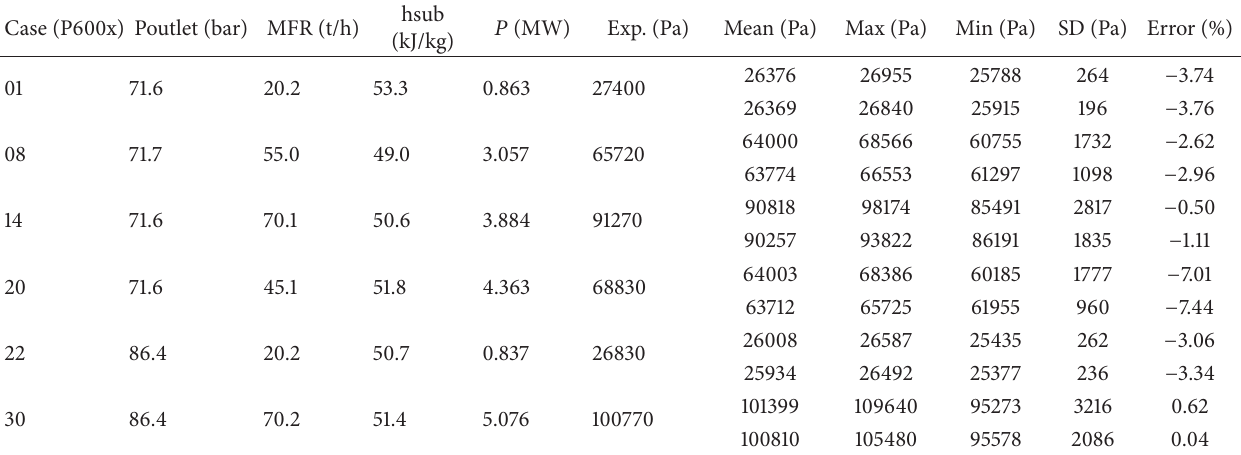
Table 5: Input parameter combinations and uncertainty results for the two-phase flow pressure drop cases.